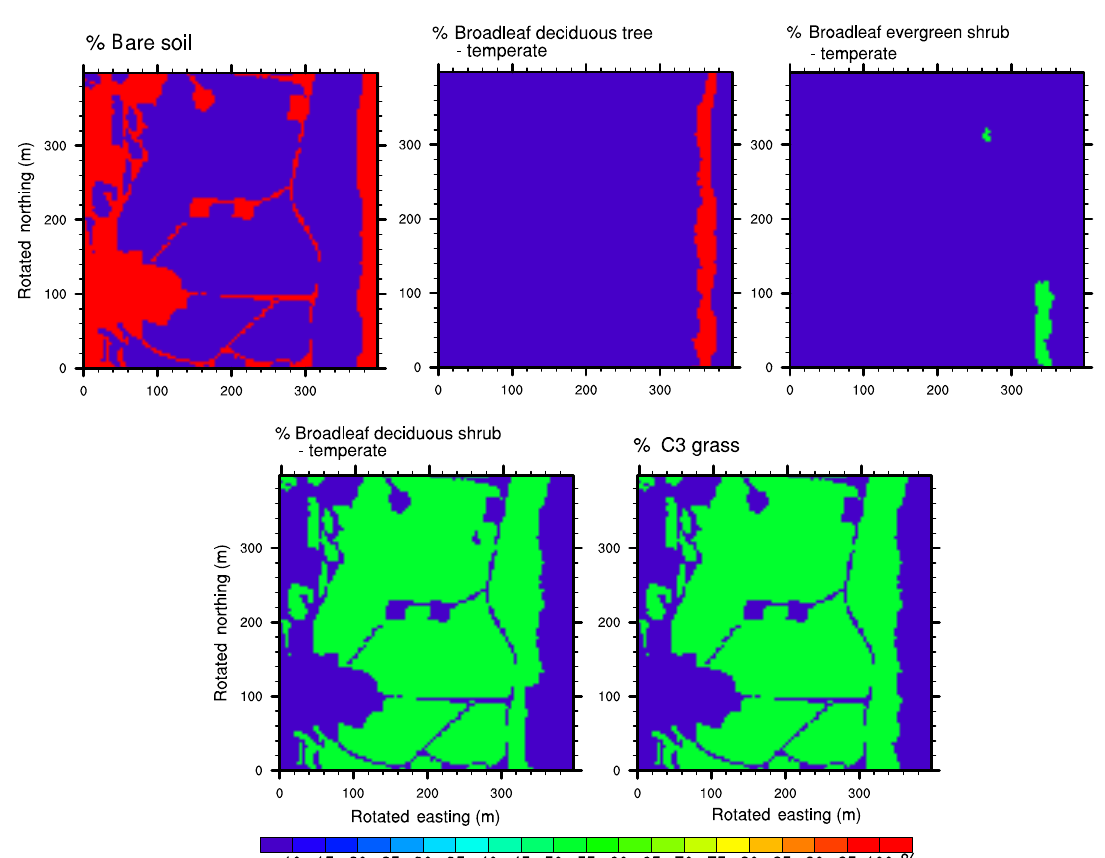
Figure 5. Plant function types at 2m resolution as inputs for